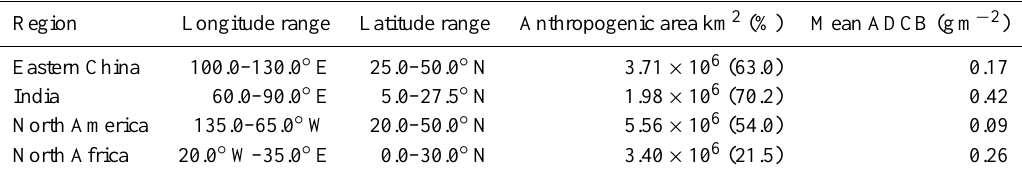
Table 2. Description of dust study areas – latitude and longitude ranges; area and percent of the region considered to contribute to anthro- pogenic dust emissions; and annual mean anthropogenic dust column burden (ADCB) of the regions considered in this study.